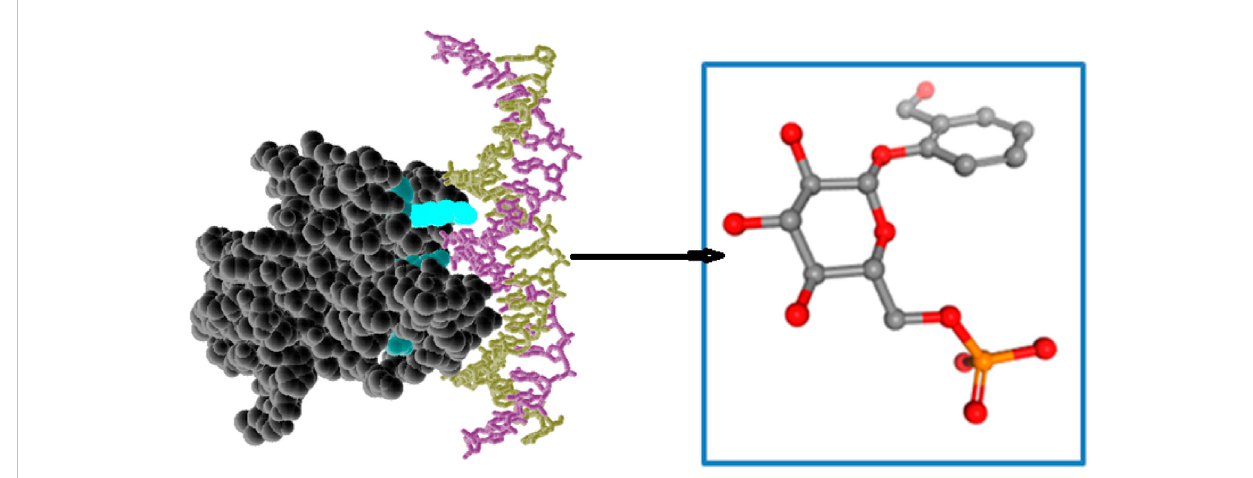
FIGURE 4 All 3 ligands attached at same binding pockets.